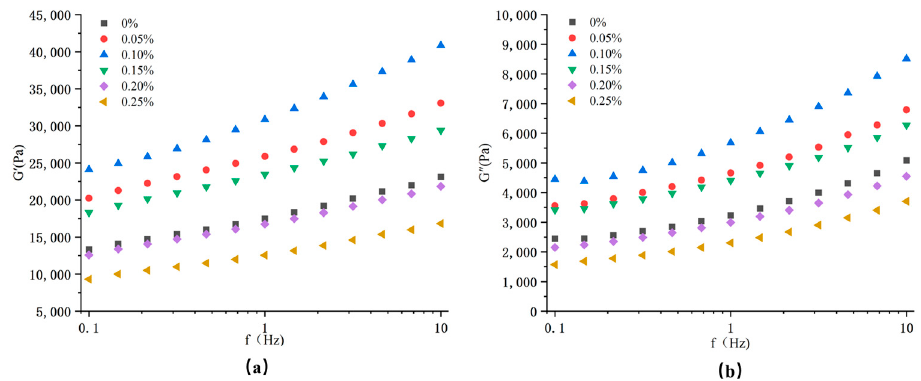
Figure 2. Storage modulus value G ′ ( a ) and loss modulus value G ″ ( b ) value of the extrudates with the different addition of cysteine.